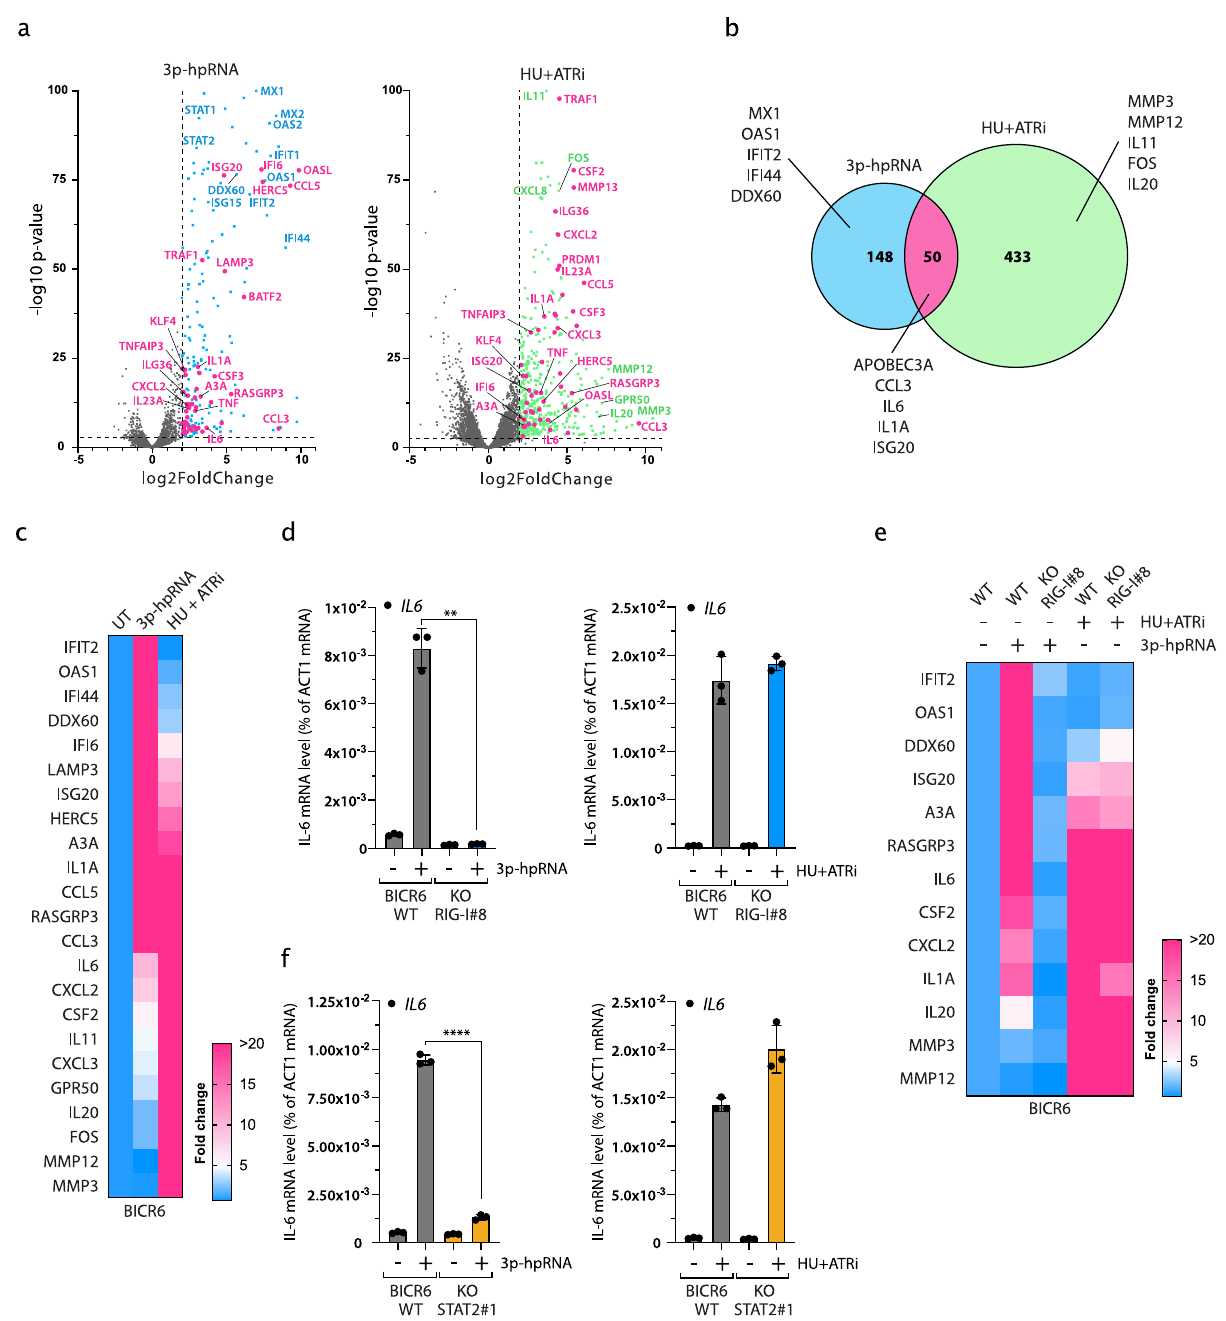
Fig. 6 Distinct innate immune signatures mediated by IFN signaling and replication stress-induced DNA damage. a Volcano plots of differentially expressed genes in BICR6 cells treated with 3p-hpRNA or HU + ATRi. Vertical dashed lines indicate a log2 fold-change of 2 and the horizontal dashed line indicates a P -value of 0.001. Data are derived from n = 3 biological replicates. b Venn diagram of signi fi cantly upregulated genes identi fi ed in a with a log2 (fold change) >2 and a P -value < 0.001. c Heat maps of 23 representative in fl ammatory genes induced after 3p-hpRNA or HU + ATRi treatment in BICR6 cells. d Quanti fi cation of IL-6 mRNA level by RT-qPCR in BICR6 WT and RIG-I KO cells after indicated treatment. Mean values ± SD ( n = 3). ** P < 0.01 (two-tailed Welch t -test). e Heat maps of in fl ammatory genes expression level in BICR6 WT or RIG-I KO treated with 3p-hpRNA or HU + ATRi. f IL-6 expression level was determined by RT-qPCR in BICR6 WT or STAT2 KO following indicated treatment. Mean values± SD ( n = 3). **** P < 0.0001 (two- tailed Welch t -test). Source data are provided as a Source Data fi